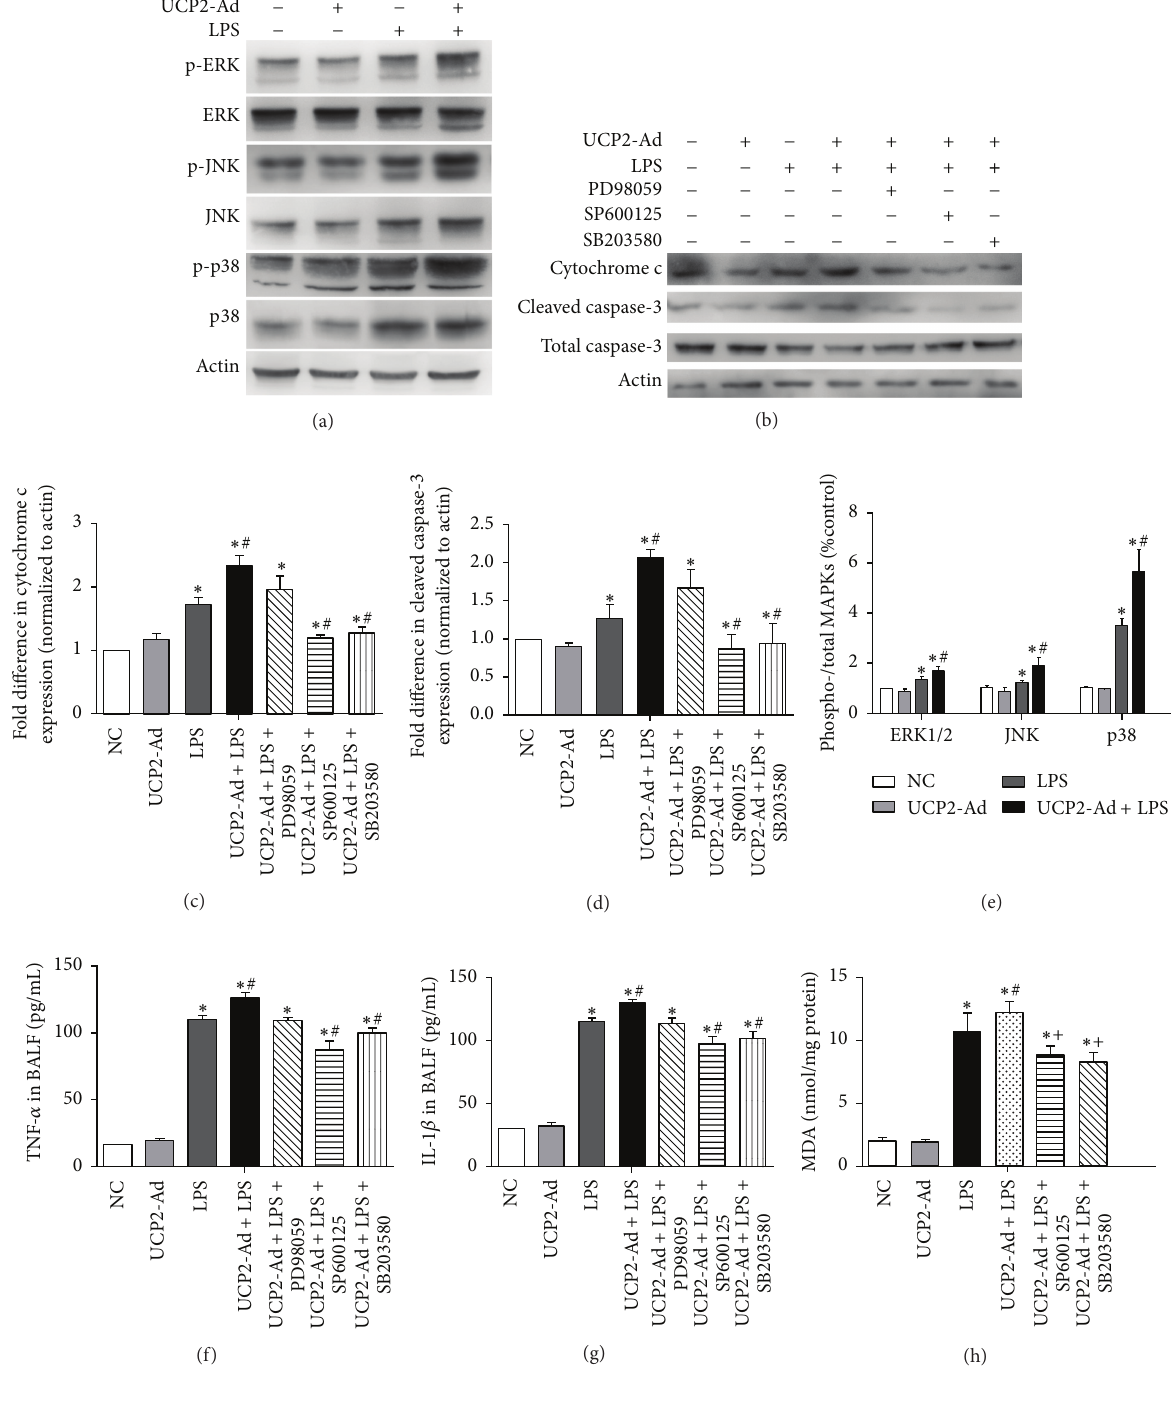
Figure 5: UCP2-induced inflammation in LPS-induced ALI is mediated by JNK and p38 MAPK pathway. (a) Western blot detected the expression of ERK, JNK, and p38 MAPKs and their phosphorylated protein in lung tissue after LPS-induced injury. (b) Western blot detected cytochrome c and caspase-3 expression after inhibition of UCP2-induced activation of MAPK signaling pathways by the inhibitors of specific MAPK signaling pathways, respectively. (c-d) Quantification of cytochrome c and caspase-3 immunoreactivity using Western blot analysis. (e) Quantification of the phosphorylated protein p-ERK, p-JNK, and p-p38 shown in graphs using densitometric analysis. (f) The levels of TNF- 𝛼 in BALF were measured by ELISA. (g) The levels of IL-1 𝛽 in BALF were measured by ELISA. (h) The levels of ROS in lung were detected by MDA assay ( ∗ 𝑃 < 0.05 versus NC group, # 𝑃 < 0.05 versus LPS group, and + 𝑃 < 0.05 versus UCP2-Ad + LPS group). Values are presented as means ± SEM ( 𝑛 = 3